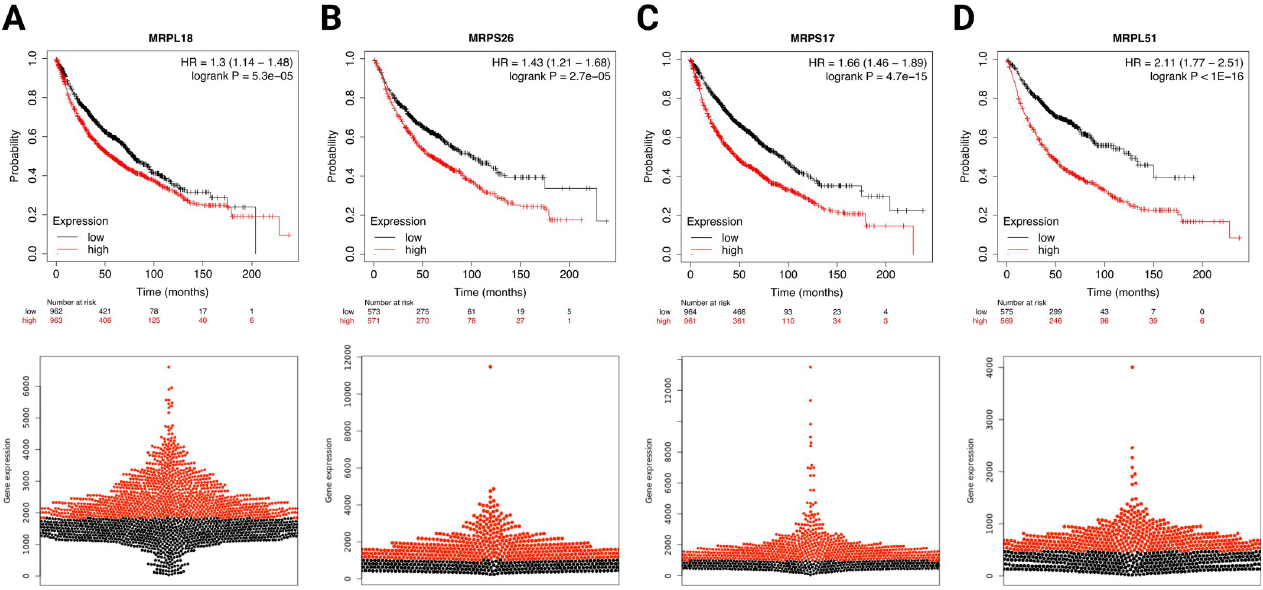
Fig 3. Association of Mitochondrial Ribosomal Protein S26 (MRPS26), Mitochondrial Ribosomal Protein S17 (MRPS17), Mitochondrial Ribosomal Protein L18 (MRPL18) and Mitochondrial Ribosomal Protein L51 (MRPL51) expression with overall survival in non-small cell lung cancer patients. Significance was determined using a log-rank P < 0.05 and the corresponding beeswarm graphs of probe distribution were displayed. HR: Hazard ratio.